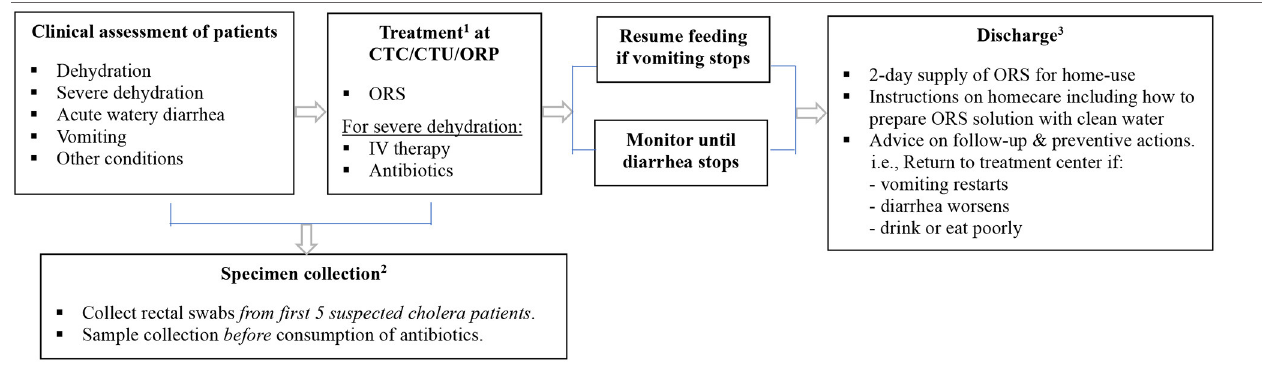
TABLE 3 | Flow diagram of cholera case management in